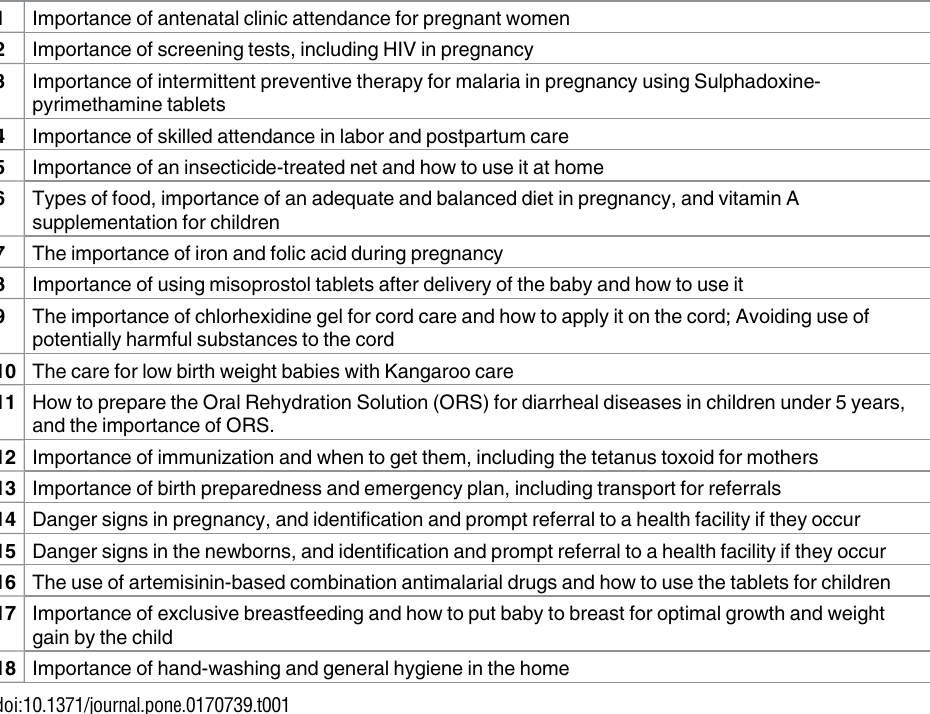
Table 1. CBHV messagesto pregnant women transmitted through pictorial counselling